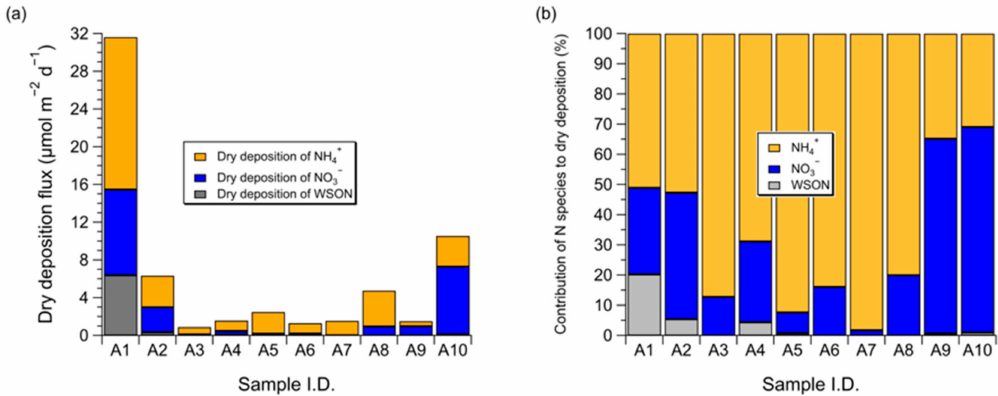
Figure 5. Variations of ( a ) dry deposition fluxes for NH 4 + , NO 3 − , and WSON, and ( b ) the contribution of each N species to dry deposition flux over the subarctic western North Pacific Ocean during the